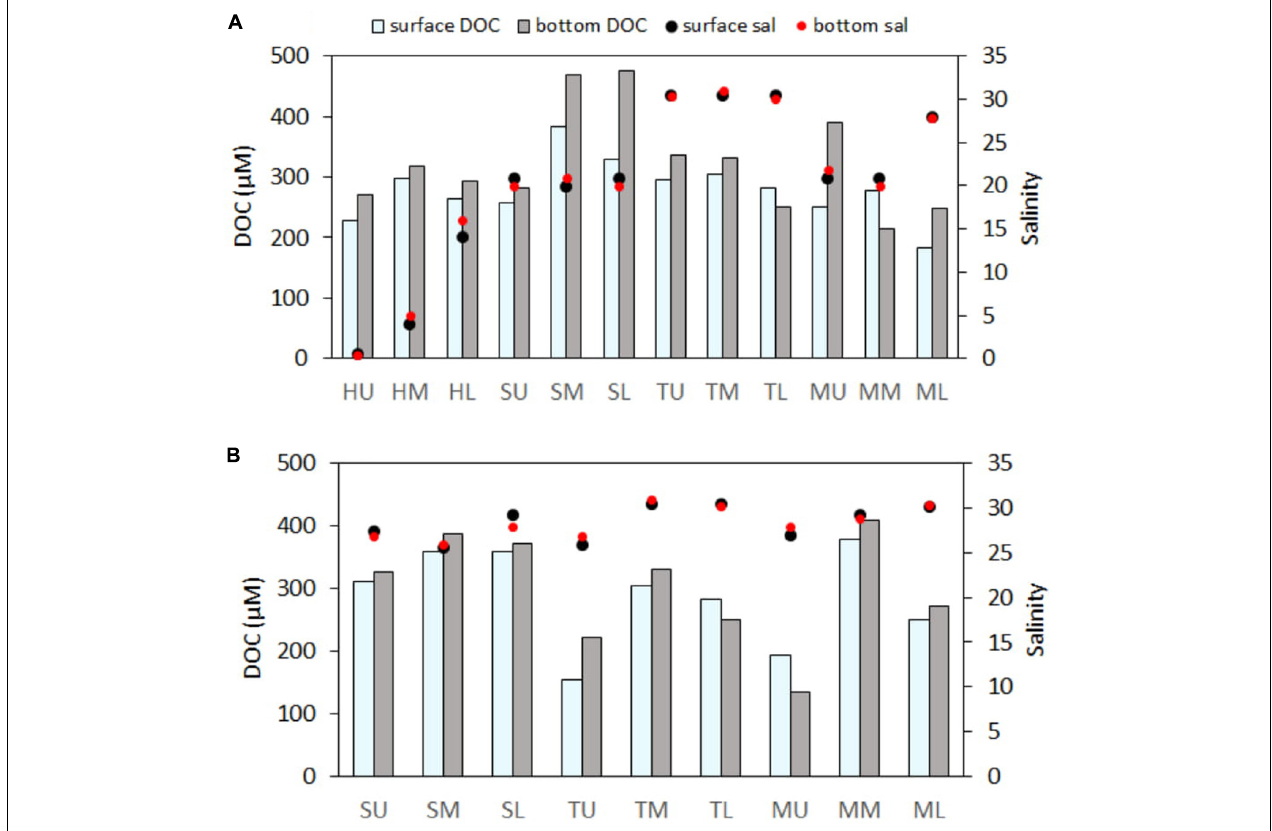
FIGURE 4 | Water column variability of DOC ( µ M) and salinity in panels (A) post-monsoon and (B)